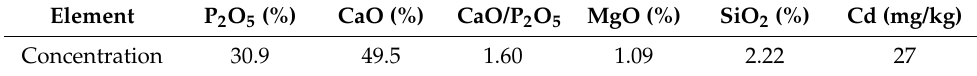
Table 7. Results of the chemical analysis of pure phosphate phase recovered by